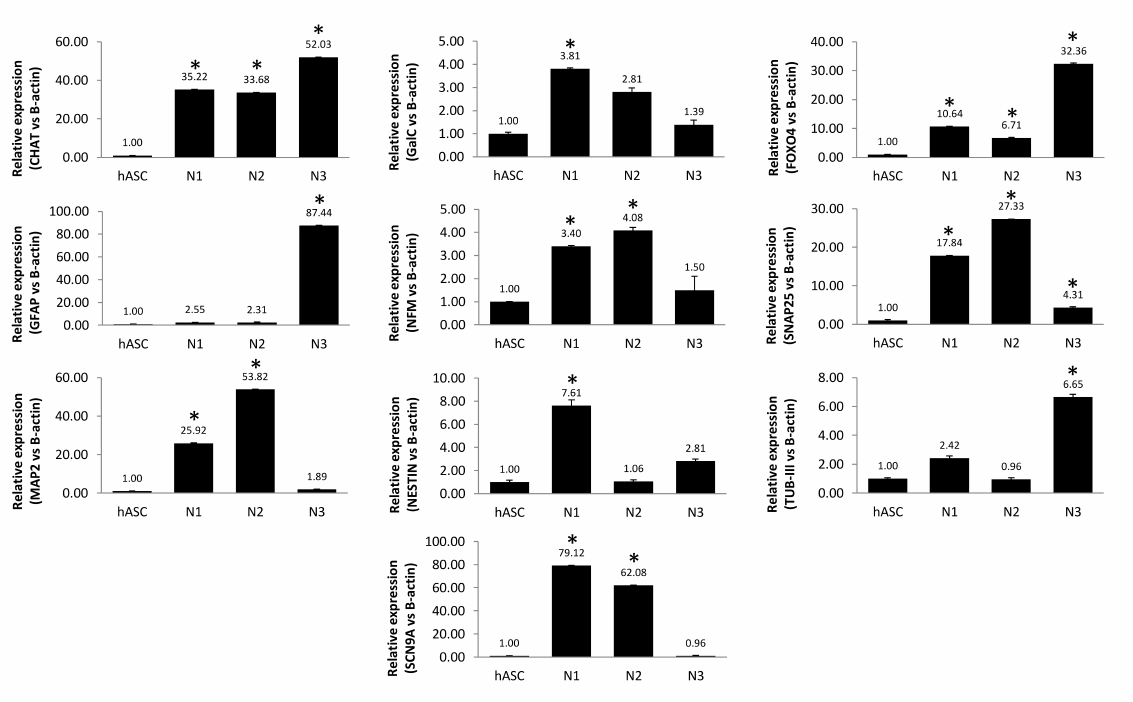
Figure 2. Quantitative RT-PCR analysis of markers in hASCs. Expression of neuronal markers was analyzed in hASCs control, hASCs induced with the Neu1 (21 days), Neu2 (15 days), and Neu3 (10 days) media. Statistically significant differences (Student’s t -test) (*) with respect to the control ( p ≤